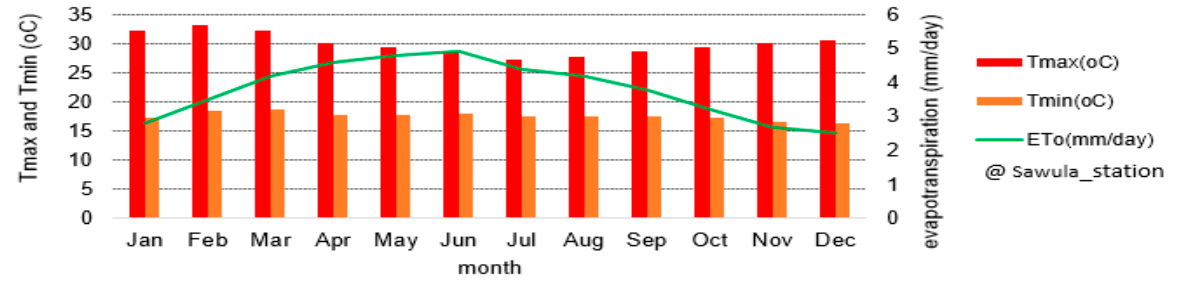
Figure 12. Average maximum and minimum temperature and evapotranspiration at Sawula weather station (1998–2018).